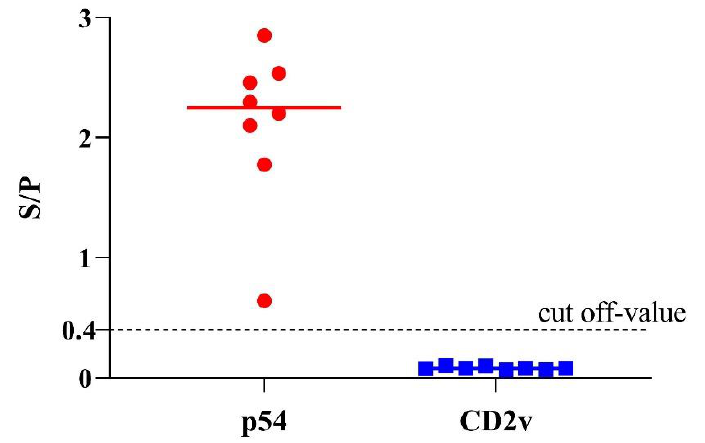
Figure 5. Detection of eight serum samples obtained from pigs infected with the new low-virulent ASFV strain in China. The data of eight positive samples are shown as dots on two vertical axes (1 = p54-ELISA and 2 = CD2v-ELISA).